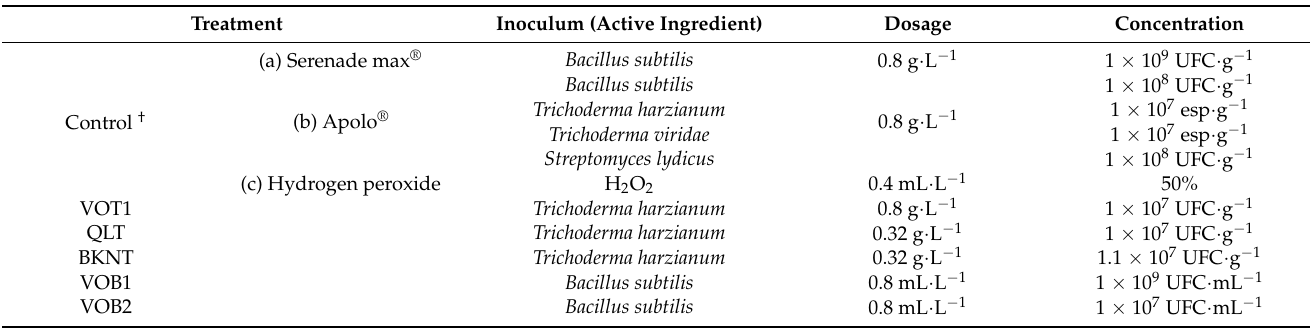
Table 2. Treatments applied in cucumber cultivation in the Fall-Winter (2015–2016) and Spring- Summer (2016)